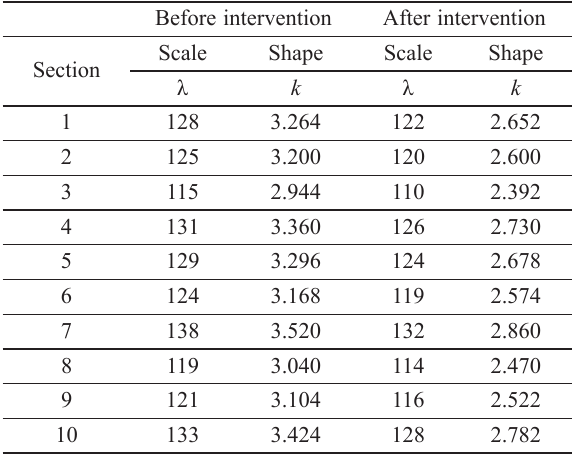
Table 2. Values of reliability parameters